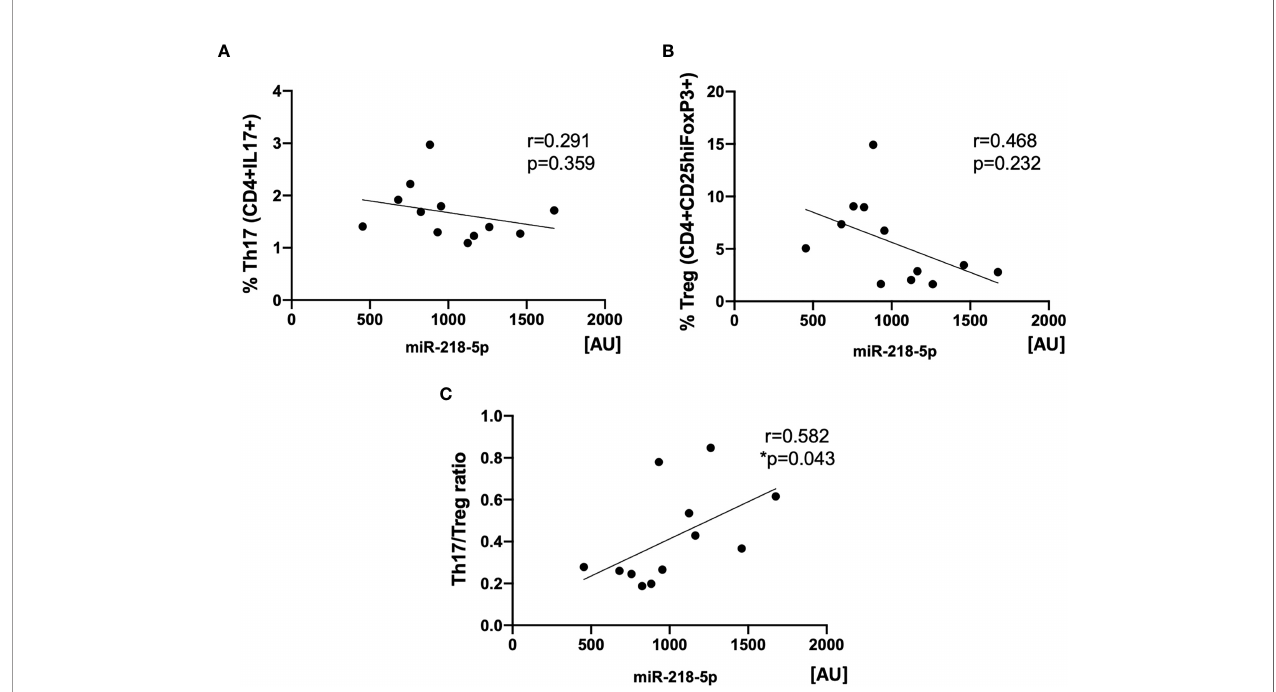
FIGURE 8 | Expression of miR-218-5p in KP-EV positively correlates with Th17/Treg ratios. (A) Correlation analysis between miR-218-5p expression in KP-EV and the percentage of Th17 (CD4 + IL17 + ) upon induction of PBMC with respective KP-EV (n=12). (B) Correlation analysis between miR-218-5p expression in KP-EV and the percentage of Treg (CD4 + CD25 hi FoxP3 + ) upon induction of PBMC with respective KP-EV. (C) Correlation analysis between miR-218-5p expression in KP-EV and Treg/Th17 upon induction of PBMC with respective KP-EV. *represents p-values ≤